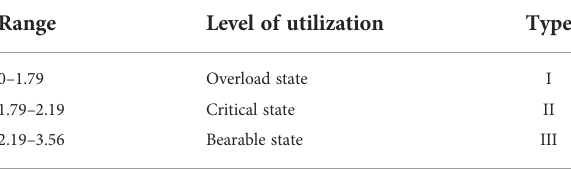
TABLE 4 Grading types of carrying capacity(Bureau of Natural Resources, Dalian). Range Level of utilization